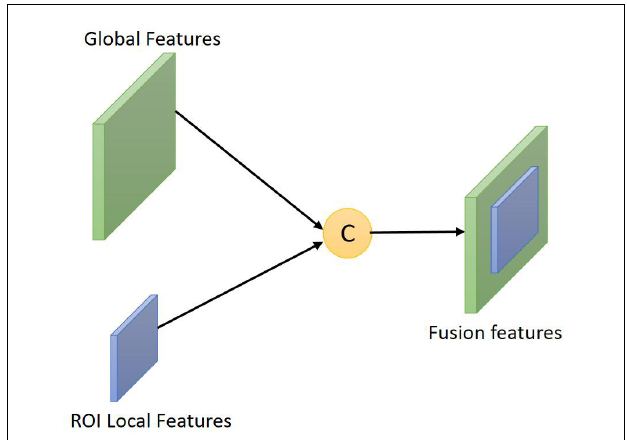
FIGURE 1 | Schematic diagram of feature fusion.